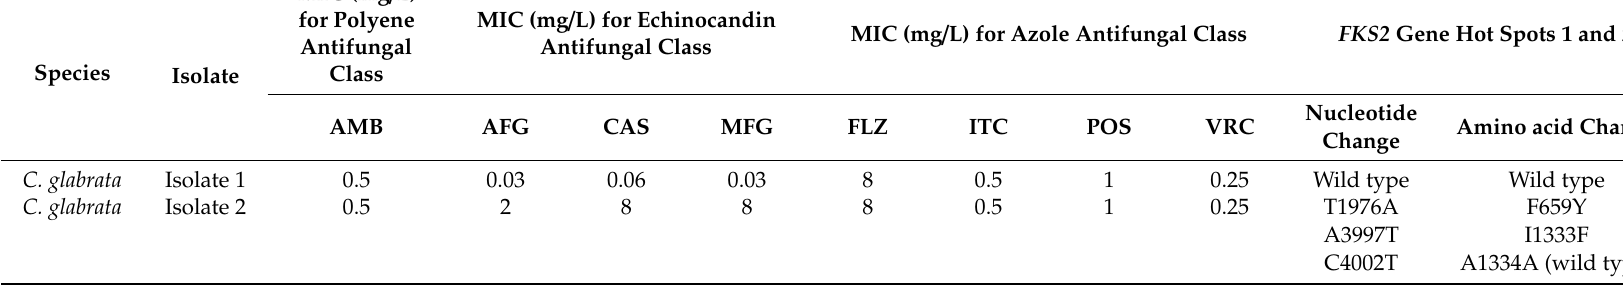
Table 1. Antifungal susceptibility testing and FKS2 gene sequencing results of two sequential candidemia